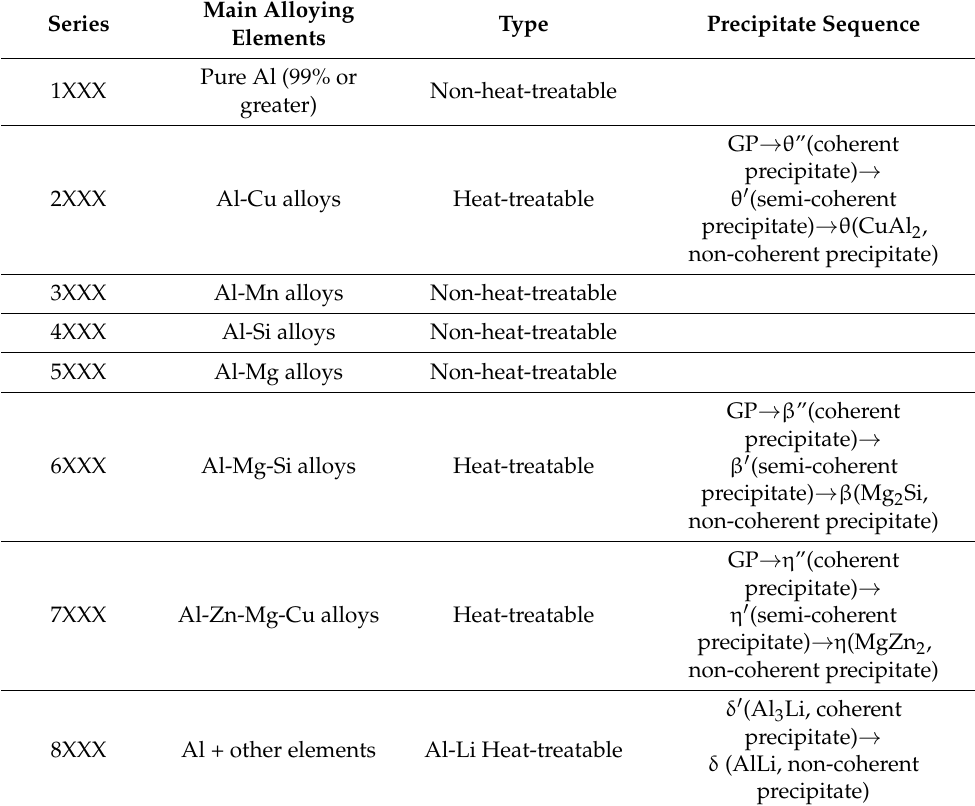
Table 1. The classification of heat-treatable aluminum alloys and non-heat-treatable alloys. Adapted from [7,12]. (Guinier-Preston zone (GP)).